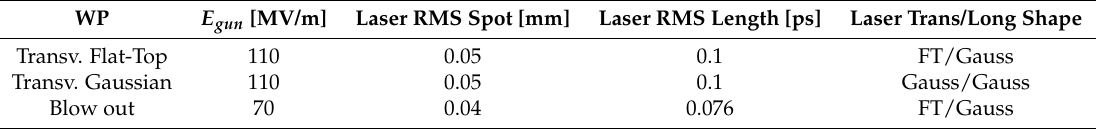
Table 3. Laser and RF gun parameters used for obtaining the beam distributions shown in Figures 8 and 9. All the working points presented are obtained for a bunch charge of 0.5 pC. In the last column, the transverse and longitudinal shaping of the laser profile are specified. The following abbreviations are used: FT = Flat-Top, Gauss =